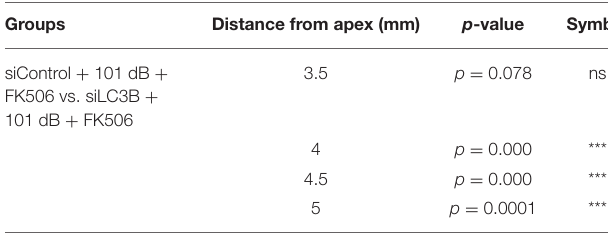
TABLE 2 | Post-hoc analysis of outer hair cell loss ( Figure 6D ).